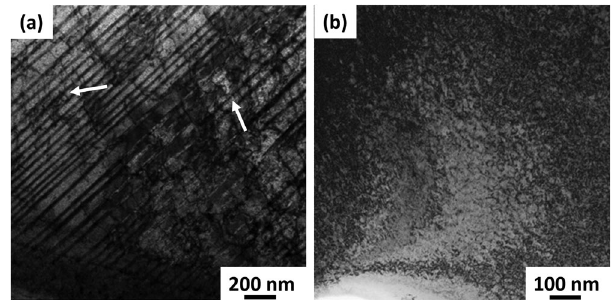
FIG. 19. Bright field TEM images of specimens extracted through thickness at the equator of the EHF niobium half-cell: (a) specimen obtained close to external surface; (b) specimen obtained close to internal